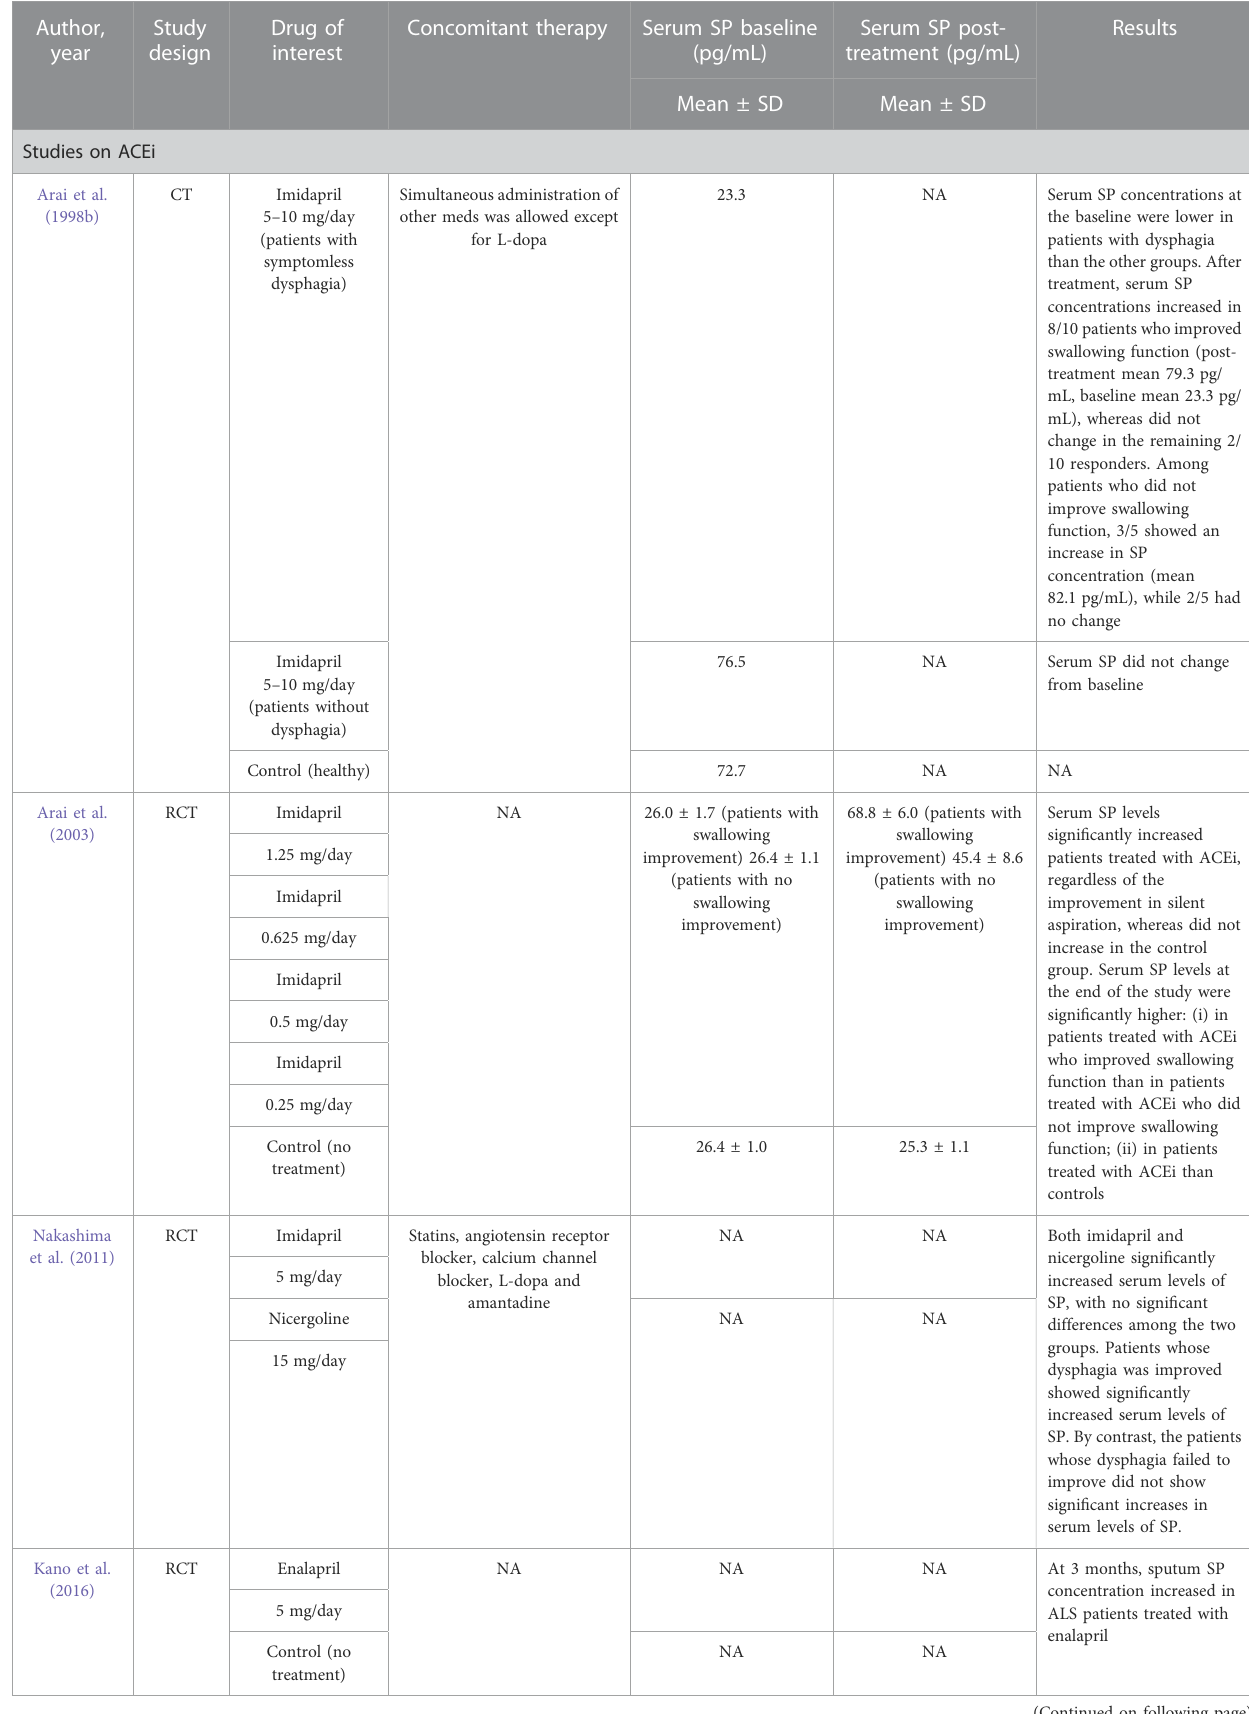
TABLE 4 Effects of pharmacological treatments on serum substance P